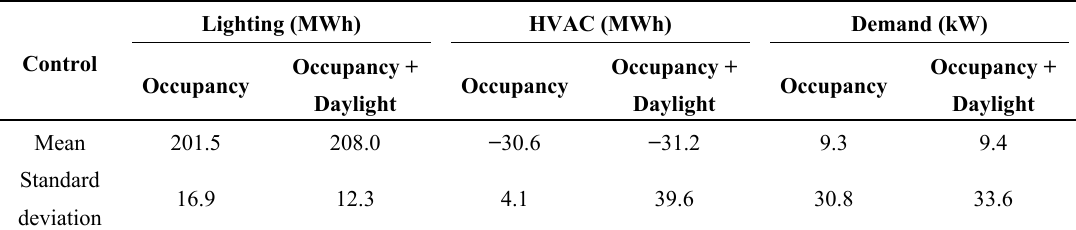
Table 1. Mean and standard deviation of lighting energy savings, HVAC energy savings and demand